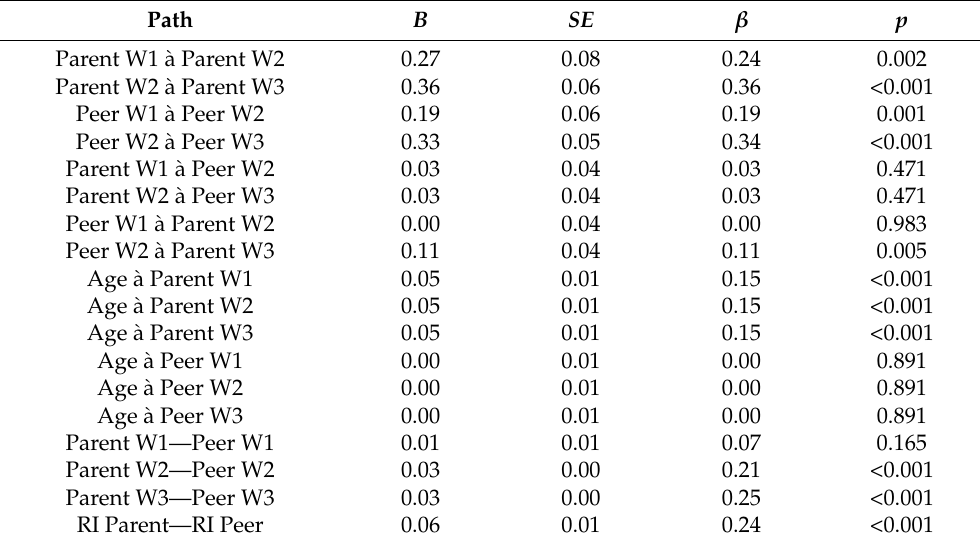
Figure 1. Random intercept cross-lagged model with standardized path coefficients from the meta- analysis. W: Wave. ** p = 0.01, *** p < 0.001. Table 3. Path coefficients of the random intercept cross-lagged panel Model 7 of parent- and peer- related loneliness.